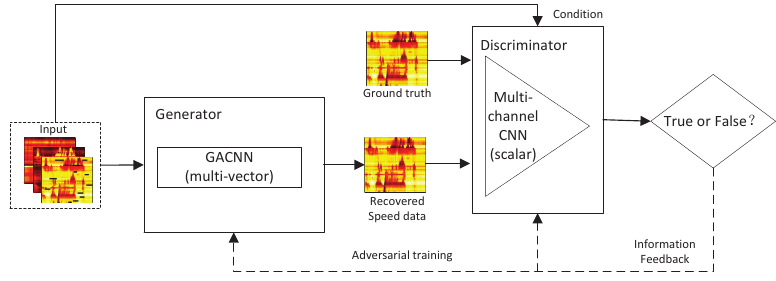
Figure 2. The geometric algebra based generative adversarial network (GAGAN).